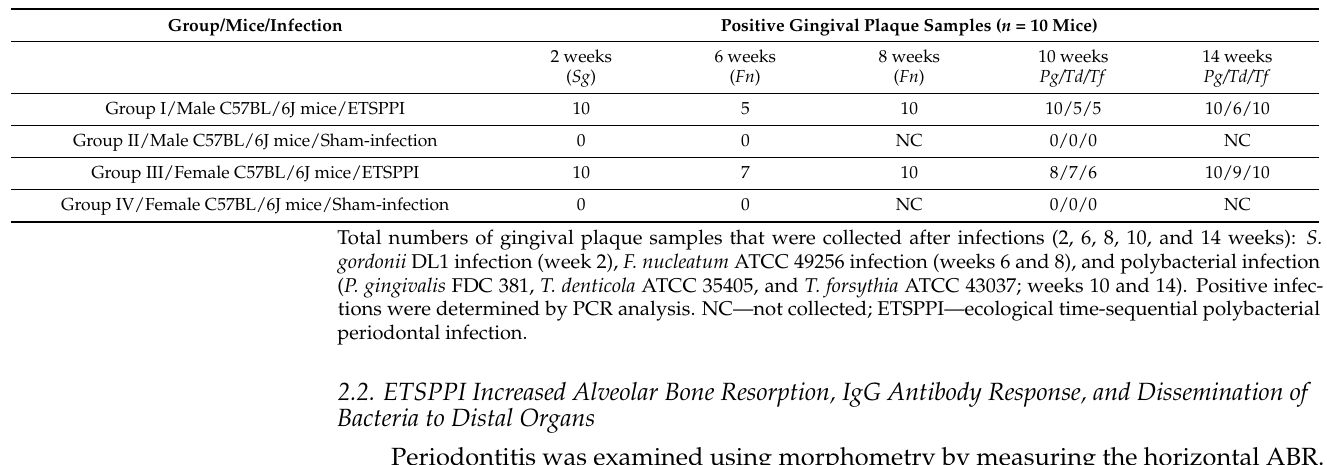
Table 2. Gingival plaque samples positive for bacterial genomic DNA by